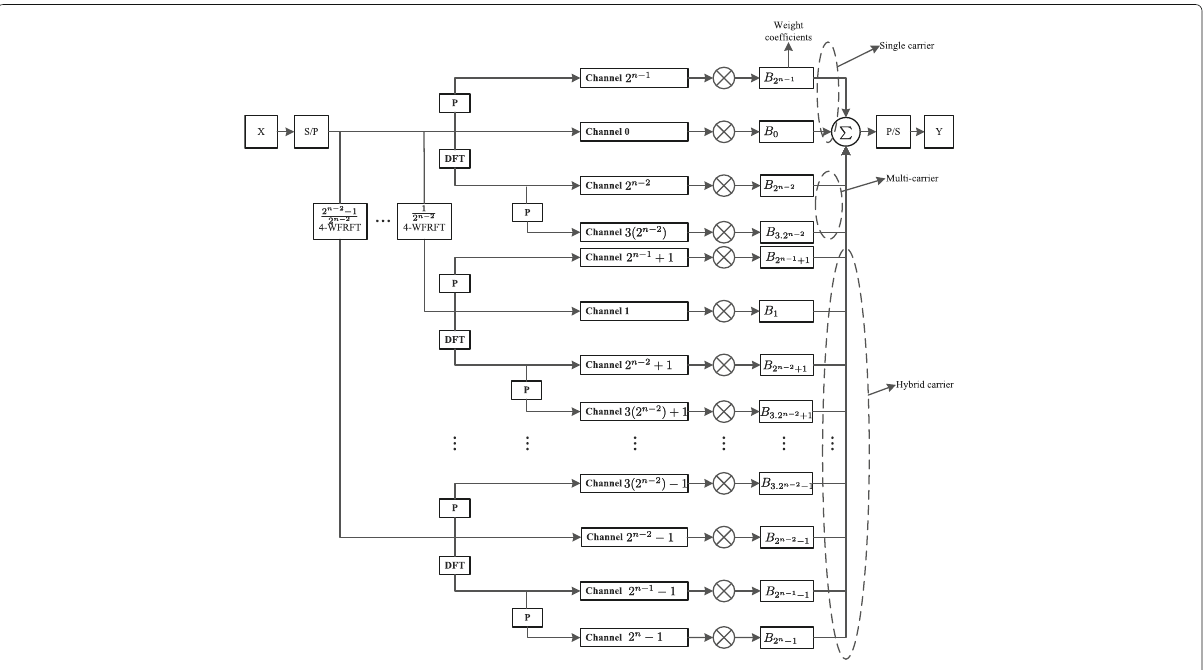
Fig. 1 Implementation structure of 2 n -WFRFT and signal compositions